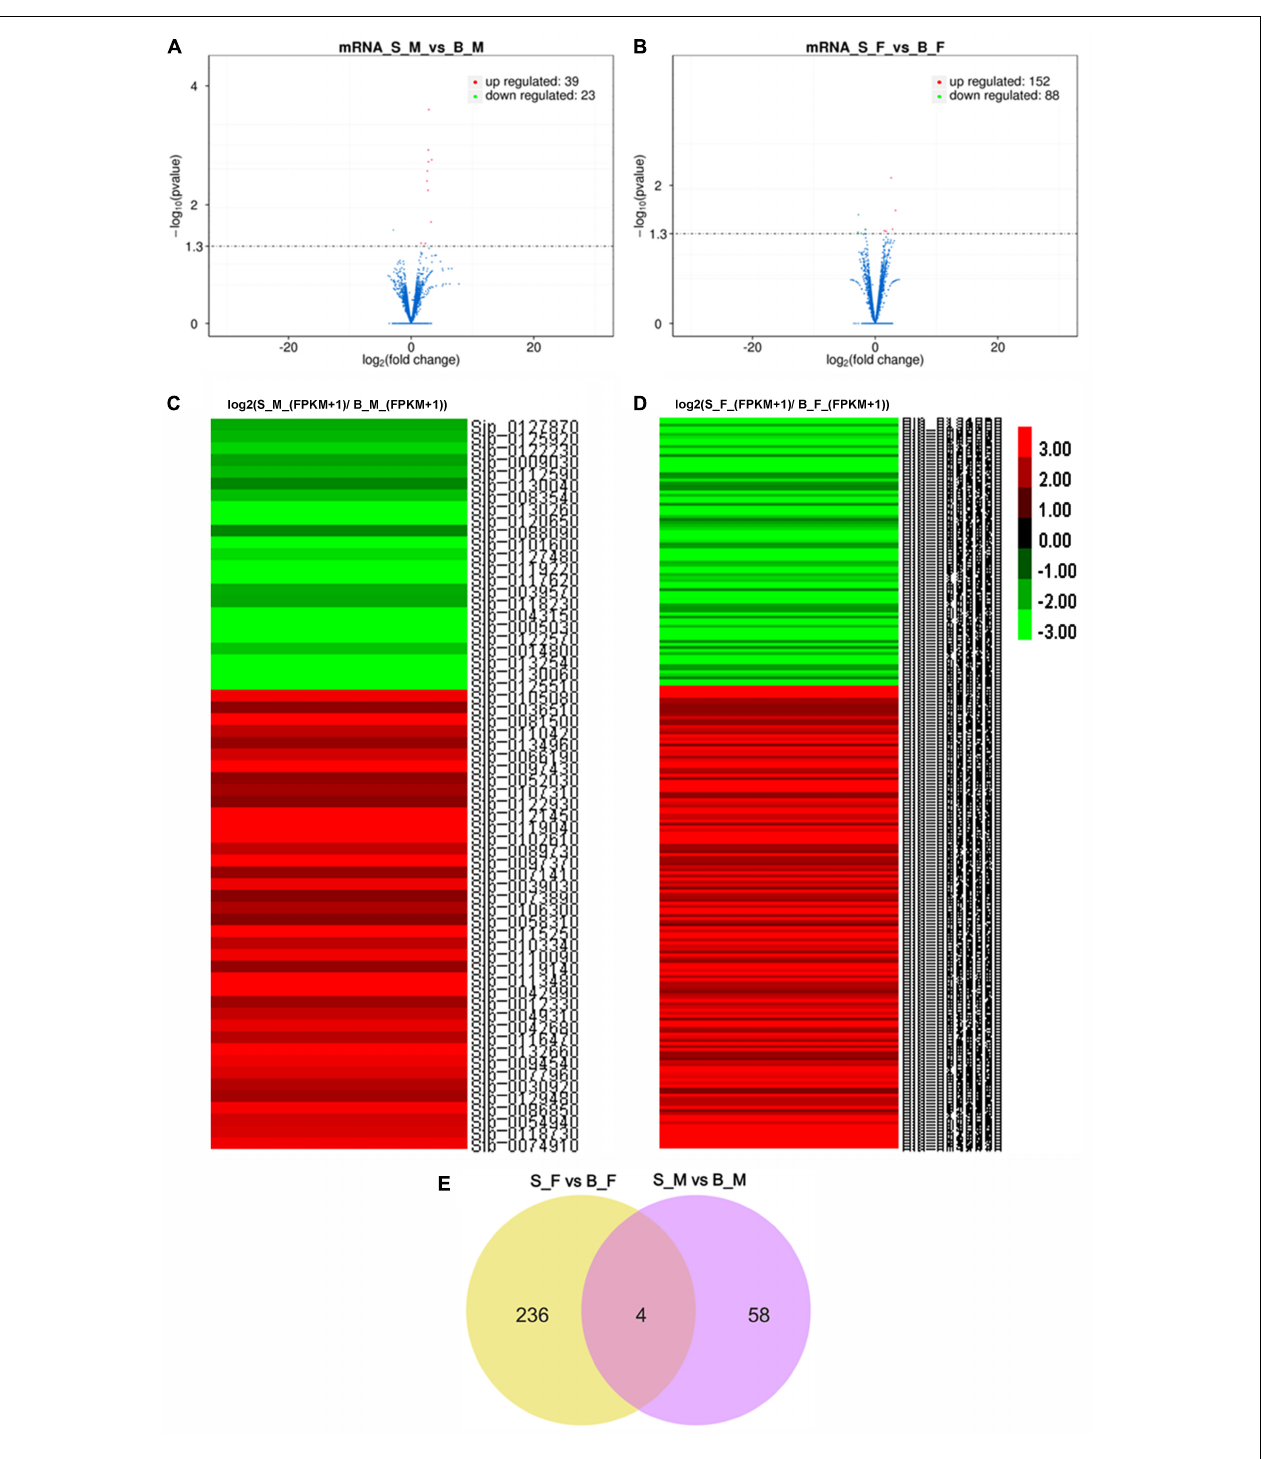
FIGURE 3 | Transcription profile analysis. (A,B) Volcano plots of the transcriptome profiles between S_M vs. B_M (A) and between S_F vs. B_F (B) . (C) Heatmap of the transcriptome profiles based on the relative FPKM value ratios [log2(S_M_(FPKM + 1)/B_M_(FPKM + 1))] of all differentially expressed genes (DEGs) in S_M vs. B_M. (D) Heatmap of the transcriptome profiles based on the relative FPKM values [log2(S_F_(FPKM + 1)/B_F_(FPKM + 1))] of all DEGs in S_F vs. B_F. (E) Venn diagram of the differentially expressed genes (mRNAs) between S_F vs. B_F and S_M vs. B_M. Higher gene expression is shown in red , and lower gene expression is shown in green . B_F female worms from BALB/c mice, B_M male worms from BALB/c mice, S_F female worms from SCID mice, S_M male worms from SCID mice.